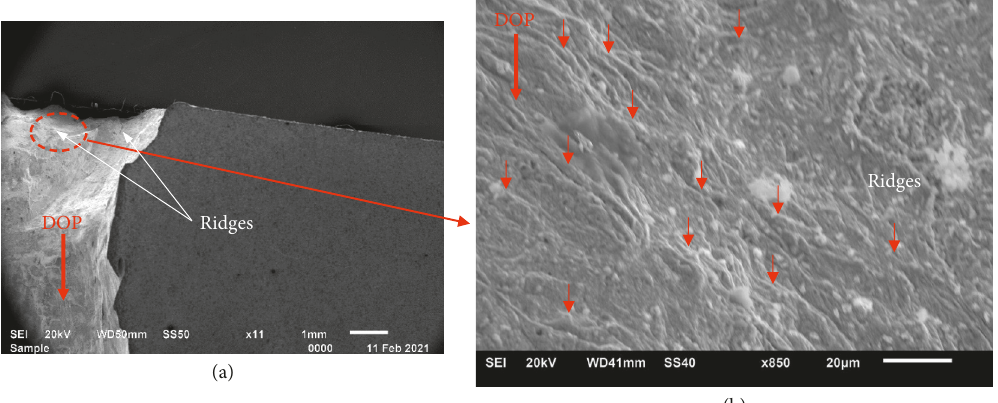
Figure 13: SEM SEI micrographs (a) at the entry point of the penetration hole through a 10mm thick plate and (b) a higher magnification micrograph of the circled area in (a).